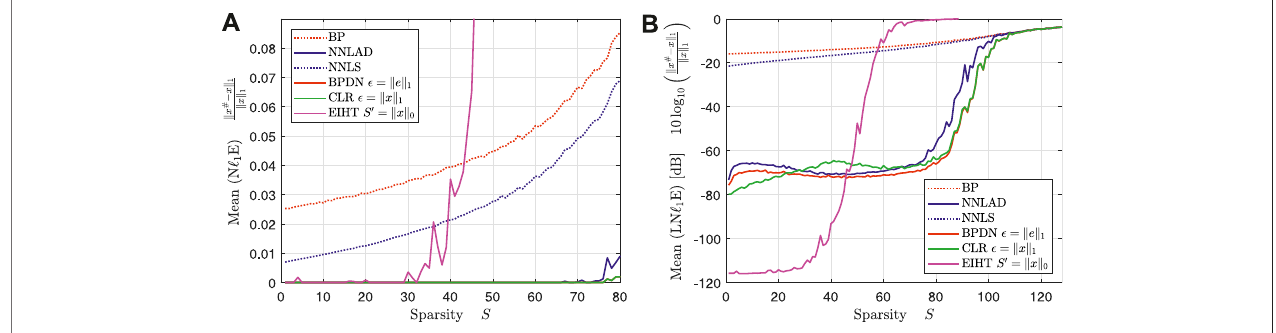
FIGURE 2| Performance ofNNLAD for noise withpeaky mass and varying sparsity of the signal. (A) The NNLS does not fail, but performs bad. (B) The NNLS and NNLAD differ strongly.